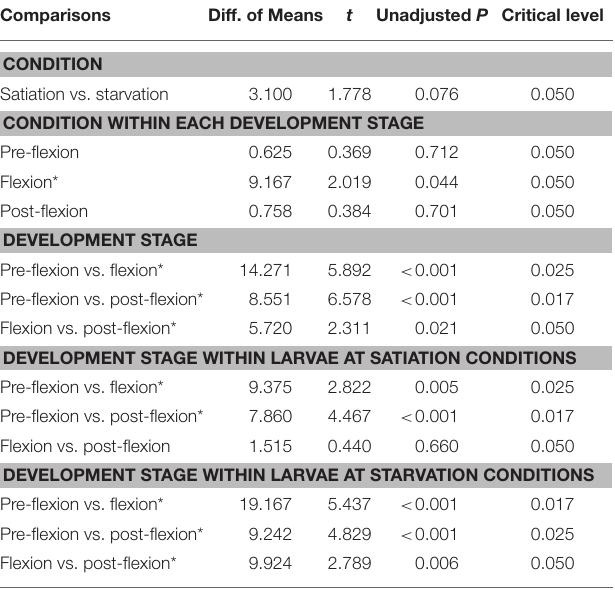
TABLE 7 | Multiple comparisons’ statistical output for the Maximum Consecutive Time (MaxCT) index calculated for all post-flexion larvae.